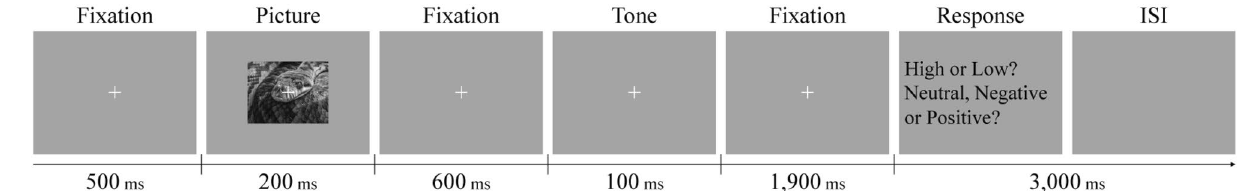
Figure 5. A diagram of the experimental procedure. In each trial, a fixation point was first presented for 500 ms. The International Affective Picture Set (IAPS) image was then presented for 200 ms. After the presentation of another fixation point for 600 ms, one of the two tones (standard or oddball) was presented for 100 ms. Each trial was separated by a response period and an inter-stimulus interval (ISI) of 3000 ms in total. Participants used the keypad to respond to the task in each block following the stimulus